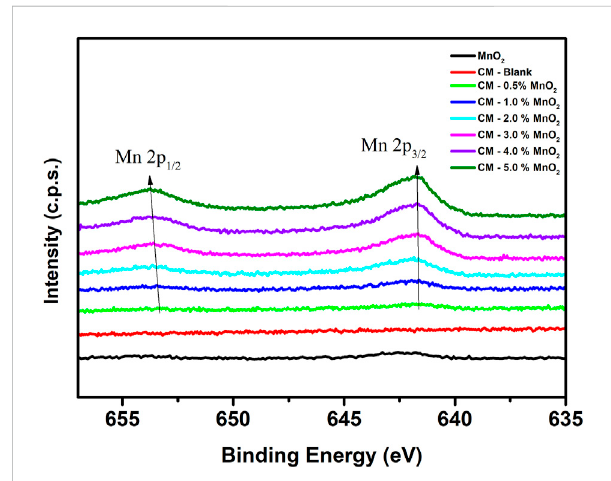
FIGURE 4 The stacked XPS spectra of Mn 2p for MnO 2 and Mn doped clinker samples (red: CM-blank, green: CM-0.5% MnO 2 , blue: CM-1% MnO 2 , cyan: CM-2% MnO 2 , magenta: CM-3% MnO 2 , violet: CM-4% MnO 2 , olive: CM-5% MnO 2 , black: MnO 2